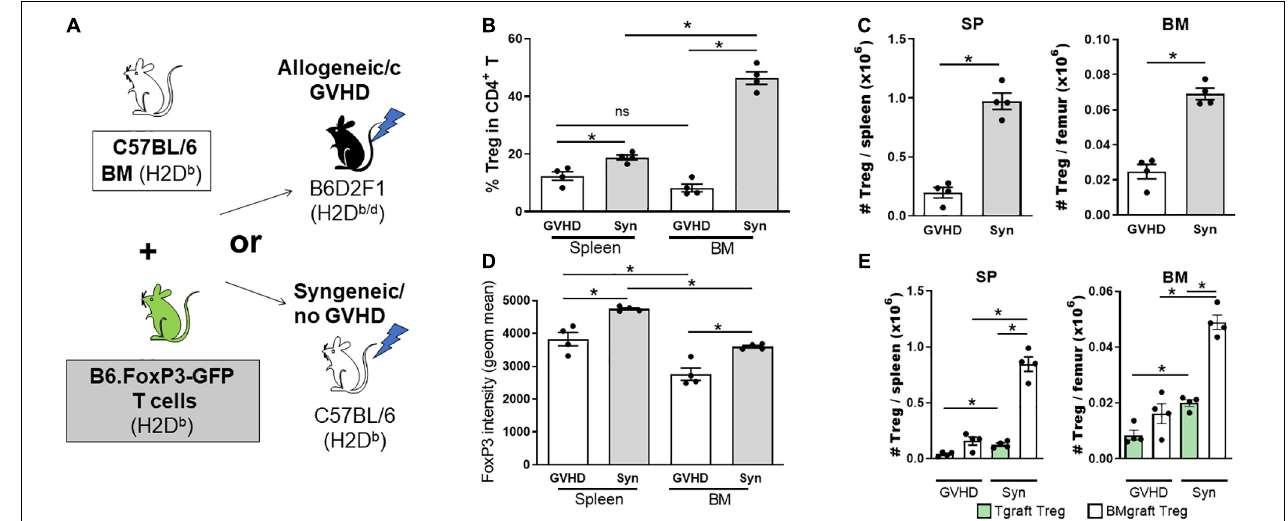
FIGURE 2 | The BMgraft is a rich source of Treg following SCT, however, BMgraft derived Treg but fail to reconstitute within the both BM and SP during cGVHD. (A–E) Cytometry analysis of FoxP3 + Treg populations 28 days following SCT. Irradiated syngeneic C57BL/6 (H2D b ) or allogeneic B6D2F1 (H2D b / d ) recipients were transplant with BMgrafts from C57BL/6 mice supplemented with SP Tgrafts from B6. FoxP3-GFP transgenic mice ( n = 4). (A) Outline of syngeneic and allogeneic transplant strategy. (B) Frequency (%) and (C) Total number of FoxP3 + CD4 + CD3 + T cells isolated from the BM and SP of transplanted mice. (D) gMFI of intracellular FoxP3 + expression in CD4 + CD3 + T cells from the BM and SP of transplanted mice. (E) Total number of Tgraft derived (GFP + ) or BMgraft derived (GFP neg ) FoxP3 + CD4 + CD3 + cells in the BM or SP of transplanted mice. Data are shown as mean ± SEM. Statistical significance was determined using an unpaired 2-tailed Mann-Whitney U test (* P < 0.05). Statistical analyses were performed using GraphPad Prism version 6.01 software. cGVHD, chronic graft versus host disease; SCT, stem cell transplantation.